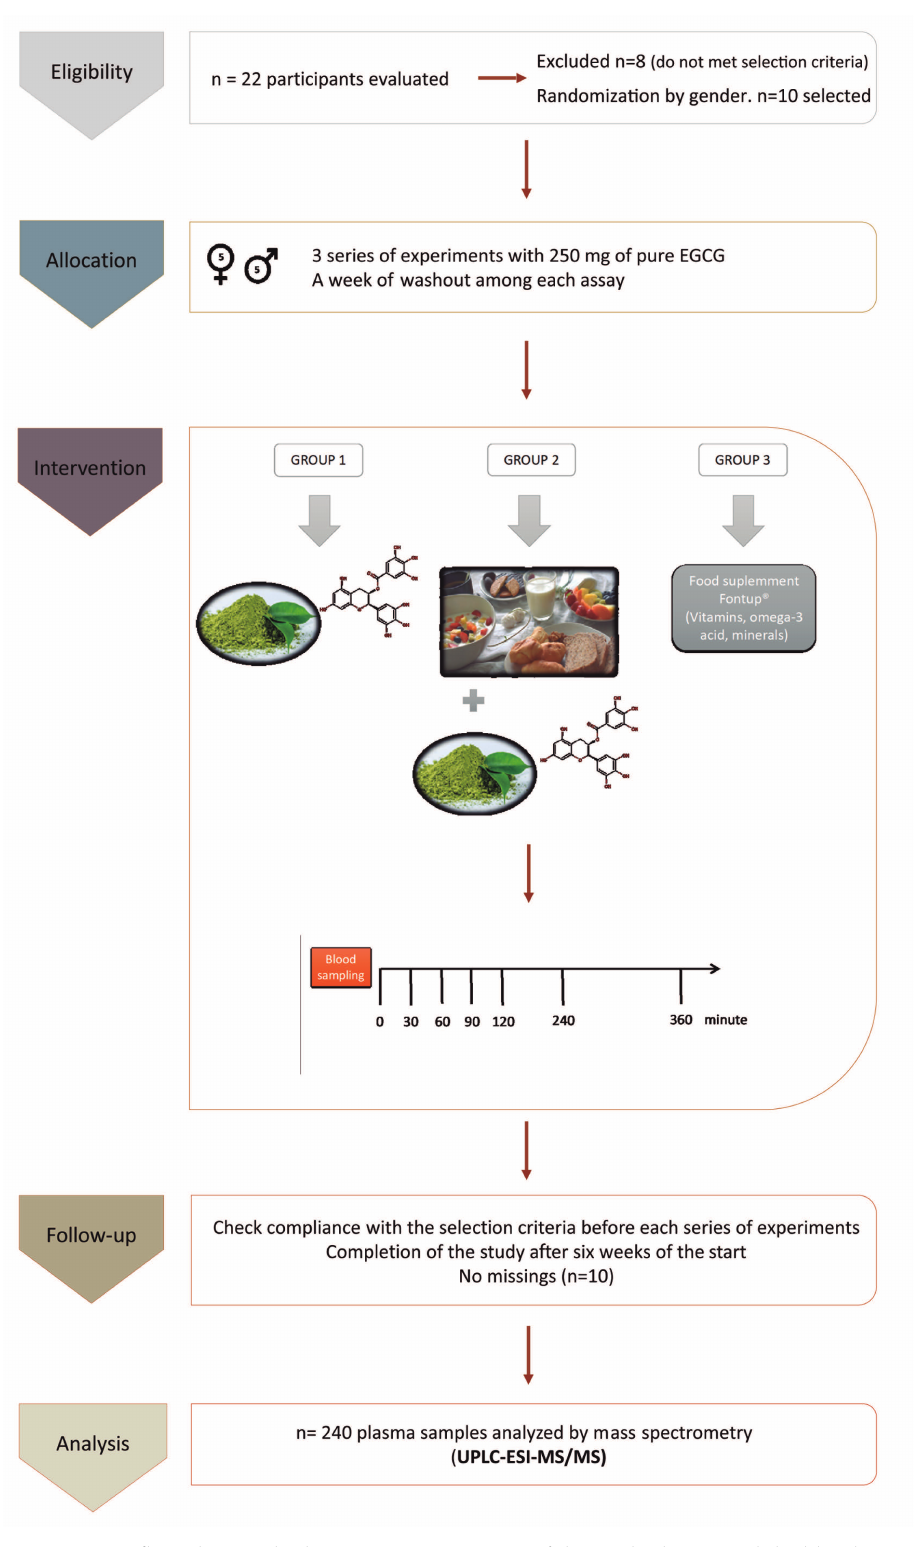
Figure 1. Consort flow chart and schematic representation of the study design and the blood sampling: The experimental design includes the study groups, the timeline of blood extractions after the intake of epigallocatechin-3-gallate (EGCG), and the methodology to analyze the samples. UPLC-ESI-MS / MS = ultra-performance liquid chromatography-electrospray tandem mass